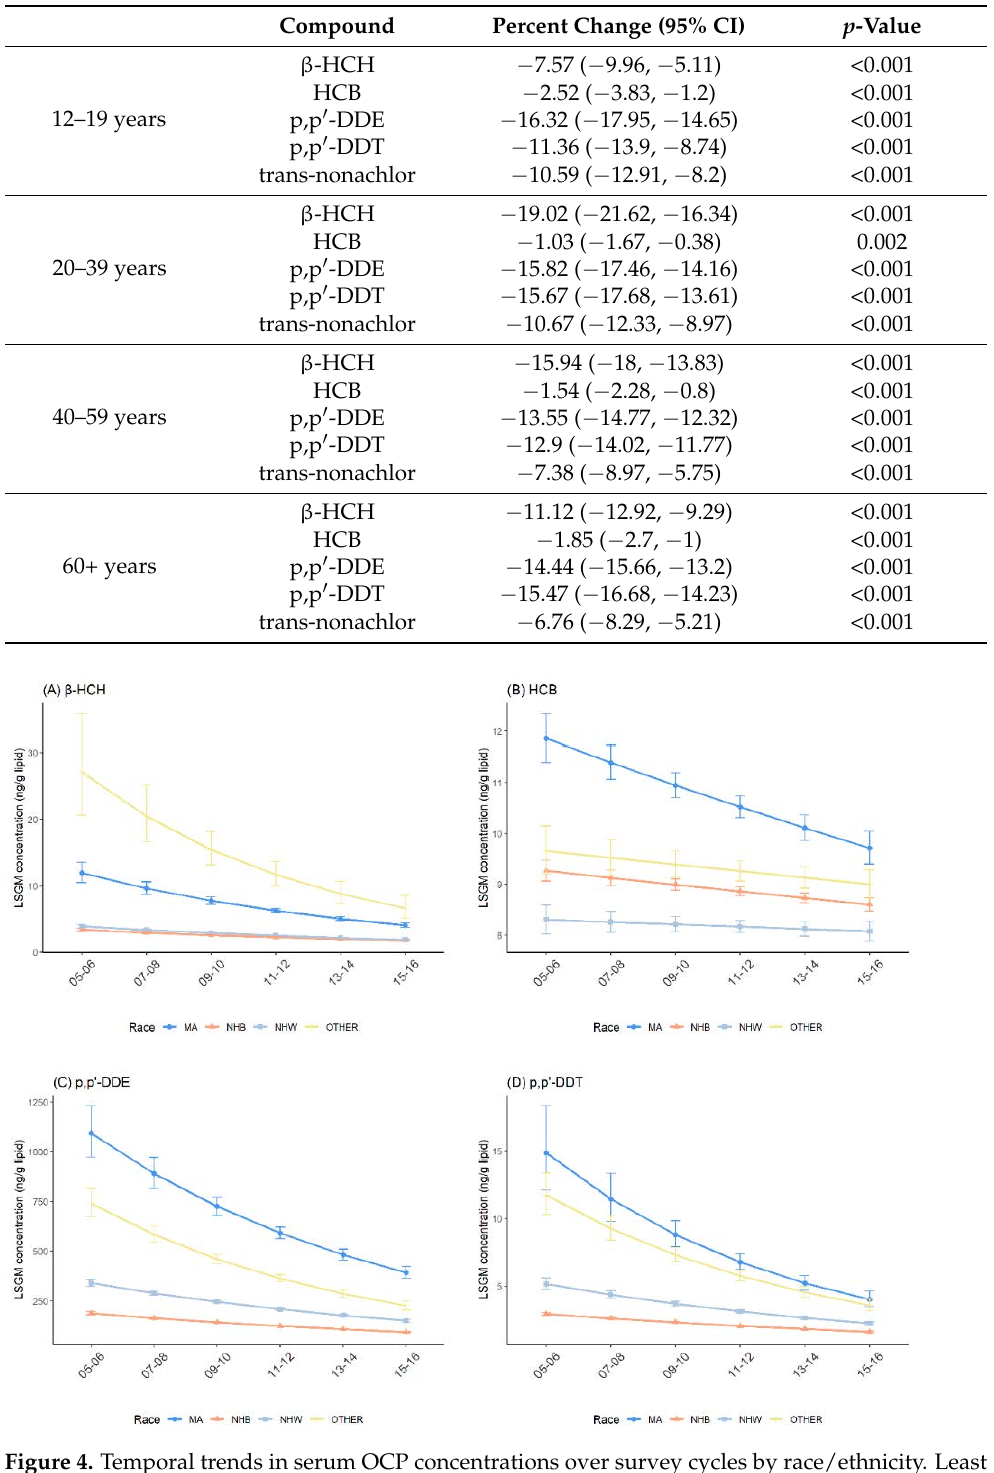
Table 5. Percent Change in Organochlorine Pesticides by the 2-Year Survey Cycle over Age Group.